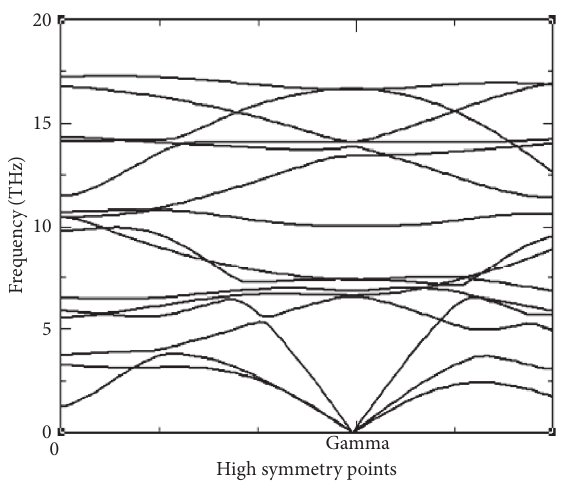
Figure 4: The phonon dispersion curve. The optical (upper) mode and the acoustic (lower) mode are clearly differentiated. Given that europium diiron diarsenide has got five atoms, there are 15 modes of vibration. The acoustic modes converge at the gamma high symmetry point as shown in Figure 4.